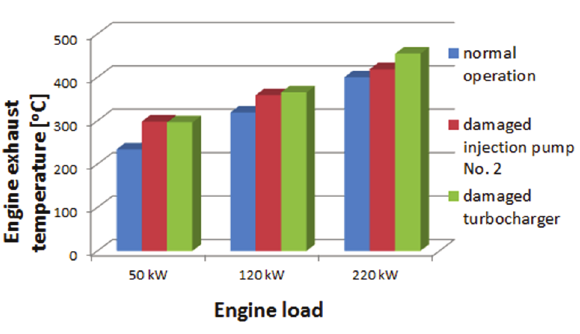
Fig. 6. Engine exhaust temperature 3AL25/30